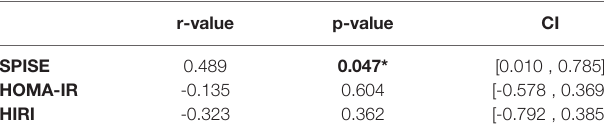
TABLE 4 | Pearson correlation coef fi cients (r) for the relation of M-value (100- 120 min.) as derived from euglycemic clamp method and hepatic insulin resistance indices (n =